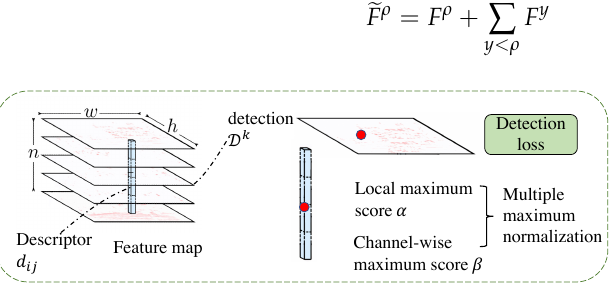
Figure 9. The calculation demonstration of the feature detection Figure 4.9.The calculation demonstration of feature detection loss